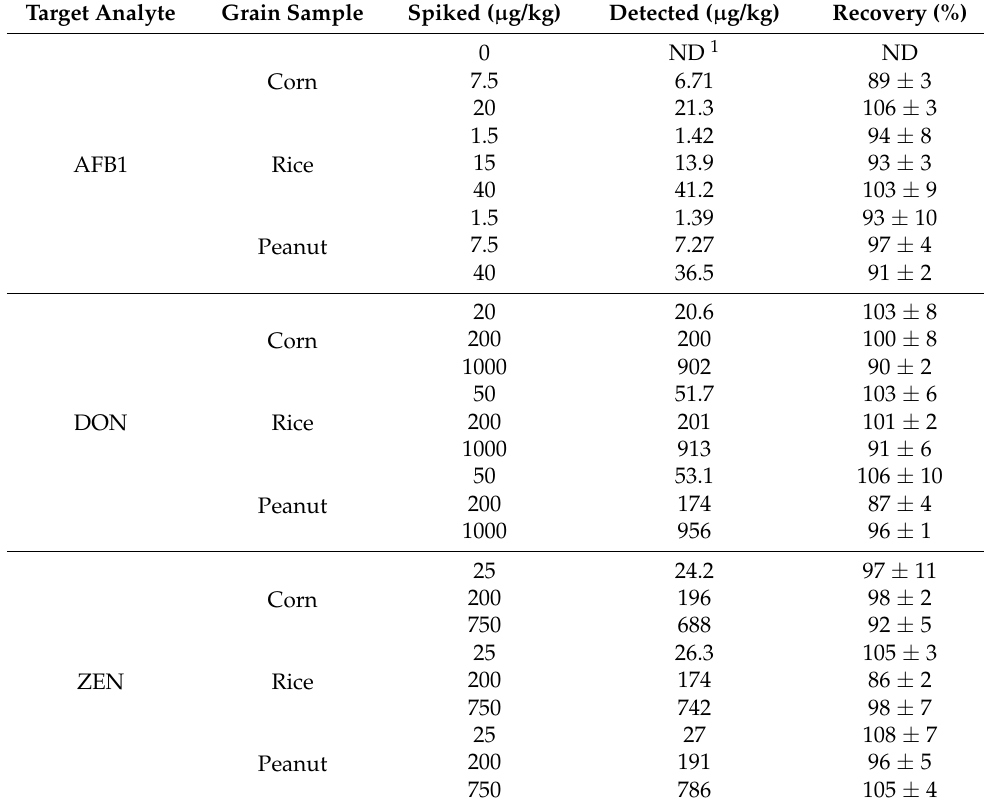
Table 1. Recovery of AFB1, ZEN and DON in different grains. Target